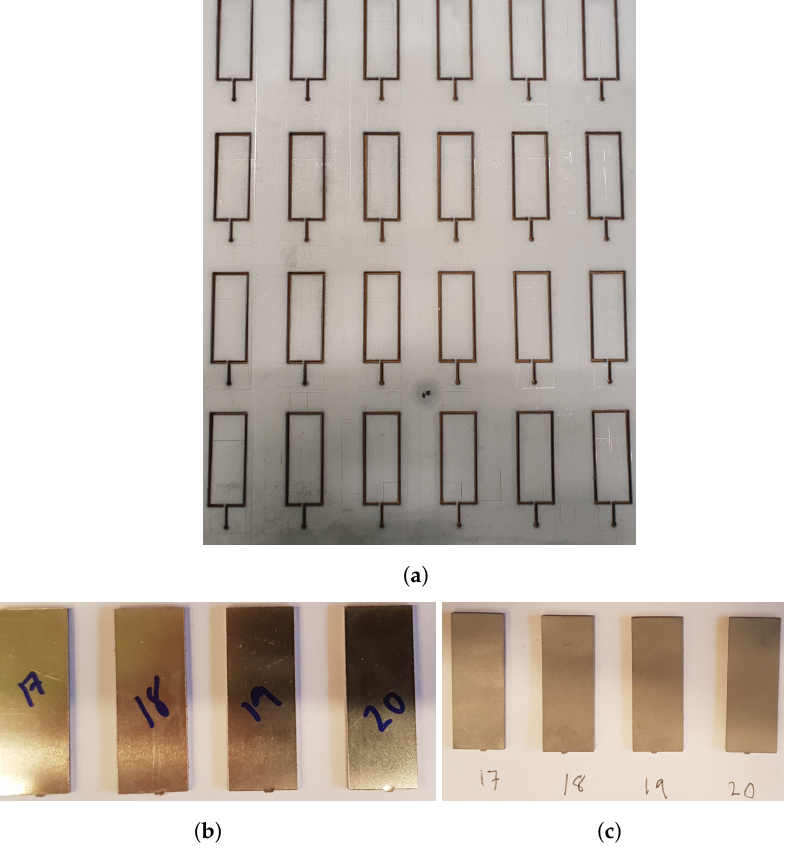
Figure 5. From the micro-sandwich sheet in ( a ), the specimens presented in ( b ) were obtained by water jet cutting. Before joining to the test tools, the test specimens were prepared using acetone and sand blasting, presented in ( c ).